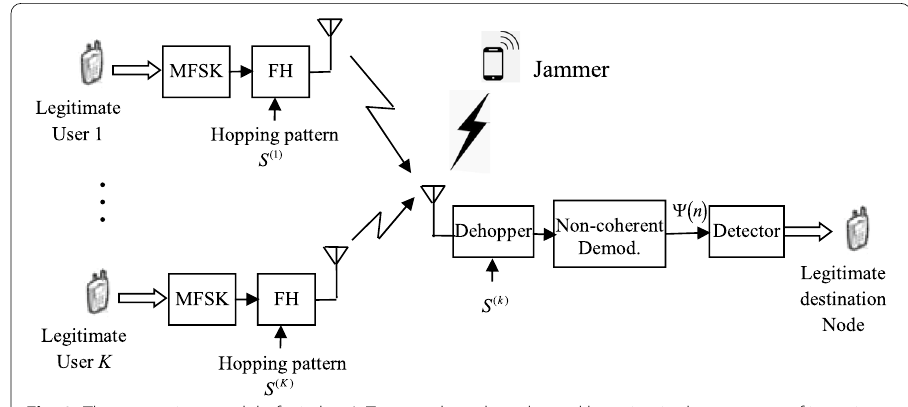
Fig. 2 The transceiver model of wireless IoT system based on channel hopping in the presence of jamming attacks